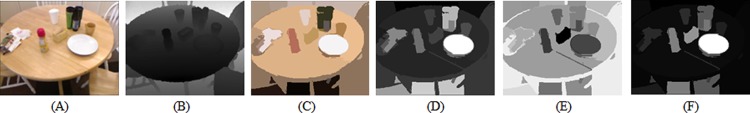
An illustrative example of our method.A: RGB image. B: depth map. C: the segmented result. For display, each region is shown in the mean color. Note that in our model, each region is assigned with a color delegation that is obtained by picking more frequently occurring colors. D: the primary saliency map. E: the background distribution map. F: the final saliency map.